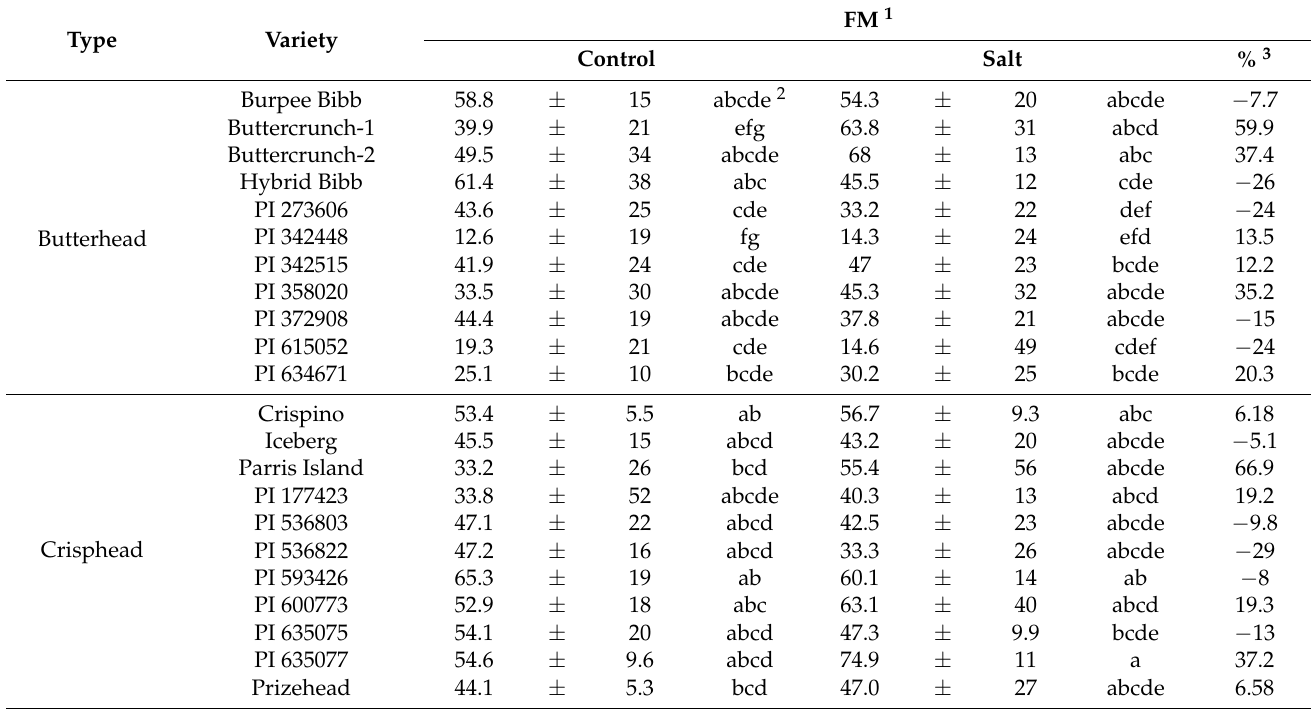
Table 3. Fresh mass (FM) (mean ± standard deviation, n = 6) of butterhead- and crisphead-type lettuce cultivars grown under control and salt-stress conditions (100 mM) after 42 days of sowing (10 days after salt treatment).